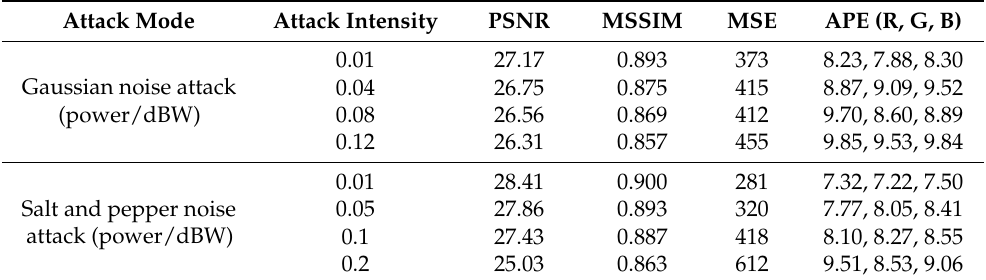
Table 2. Evaluation indexes of reconstructed secret images under container images with different noise attacks in Figures 10 and 11.